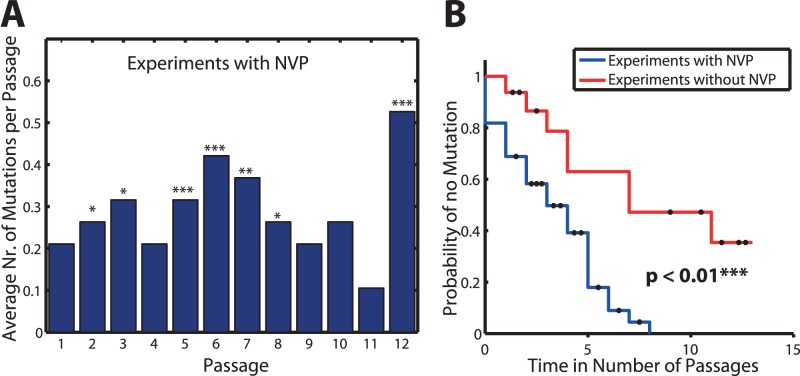
Selection dynamics.A: Average number of mutations per passage in experiments with NVP (experimental set-ups C, D, E & F). Asterisks indicate whether there were significantly more mutations (Wilcoxon rank sum test) than in the NVP-free experiments (experimental set-ups A & B). *p<0.1, **p<0.05, ***p<0.01. B: Cumulative probability of detecting no mutation. The blue and red lines show the cumulative probability of not detecting a mutation after the indicated numbers of passages (x-axis) in experiments where NVP was added with increasing concentrations (blue line; experimental set-ups C, D, E & F) vs. experiments where no NVP was added (red line; experimental set-ups A & B).